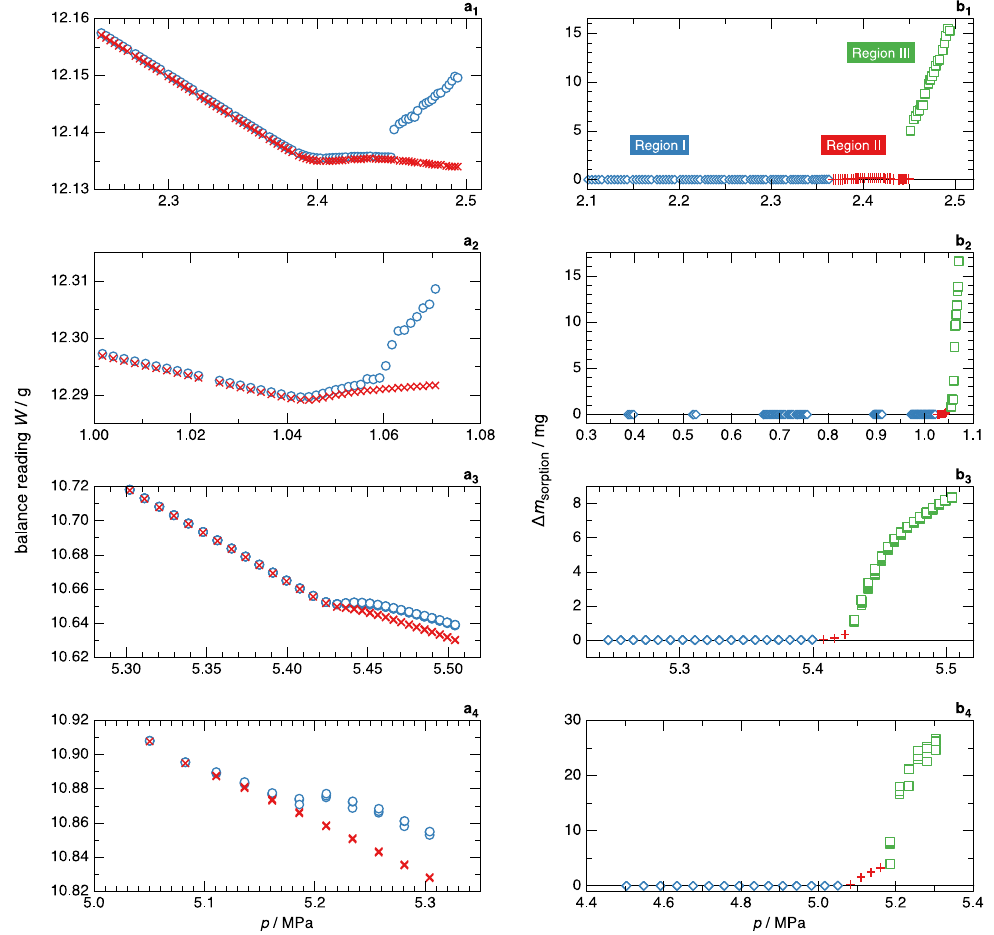
C 3 H 8 ; (a 2 and b 2 ): 0.50 CH 4 + 0.50 C 3 H 8 ; (a 3 and b 3 ): 0.75 CO 2 + 0.25 Ar; (a 4 and b 4 ): 0.50 CO 2 + 0.50 Ar; the temperature was 273.15 K for all tests shown. Regions I, II, and III are defined in the section Isothermal